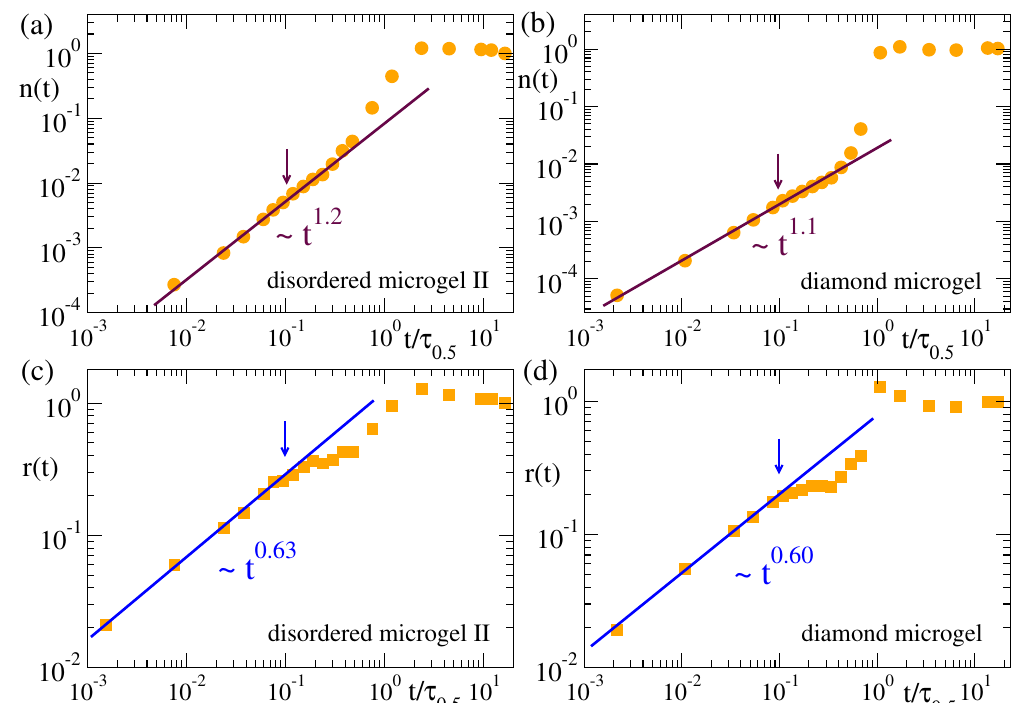
Figure 6. Normalized population ( a , b ) and radius ( c , d ) of the clusters in the density field representation of the disordered microgel with middle asphericity ( a , c ) and the diamond microgel ( b , d ). Data correspond to a solvent quality parameter φ = 1.2, and a density field representation with parameters r c = 1.0 and ρ min = 0.6. The arrows indicate the time scale for which N clus ( t ) = N ∗ ≈ 400. Times are rescaled by τ 0.5 as defined in Figure